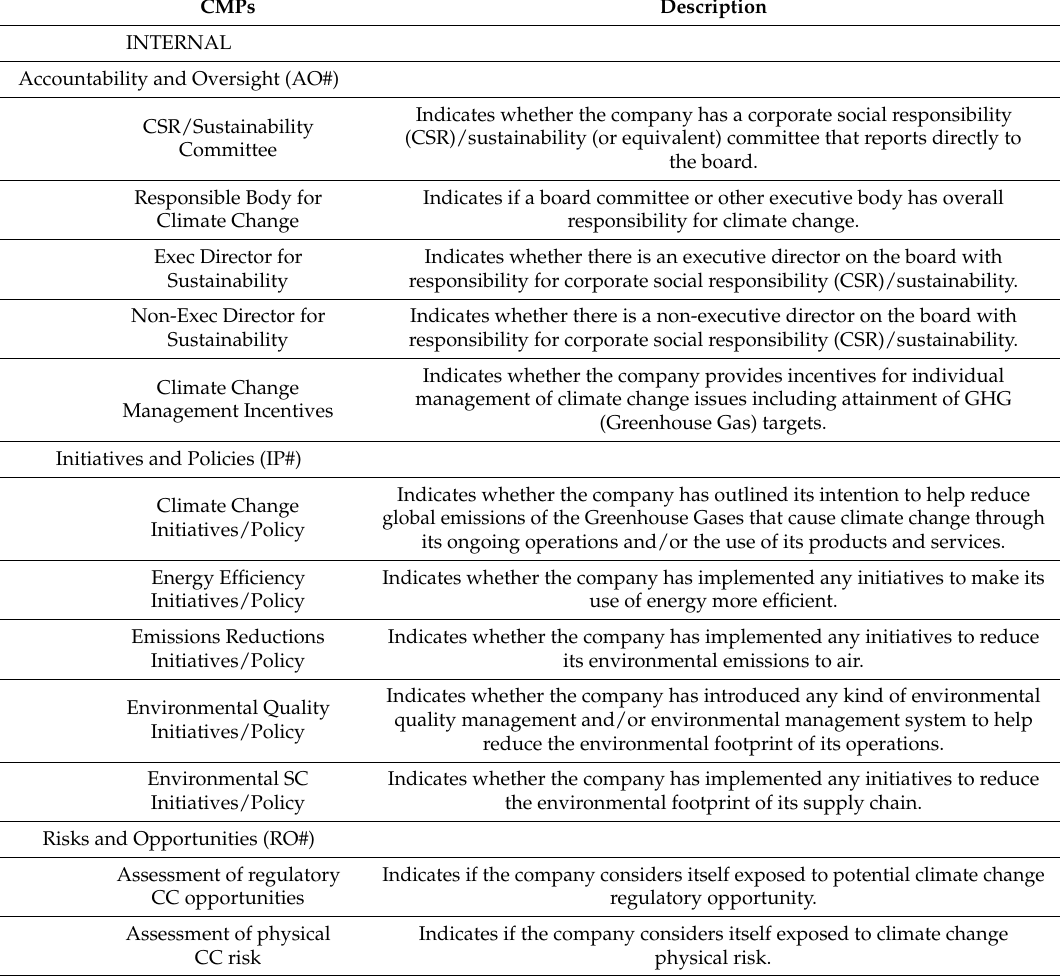
Table 1. Carbon management practices